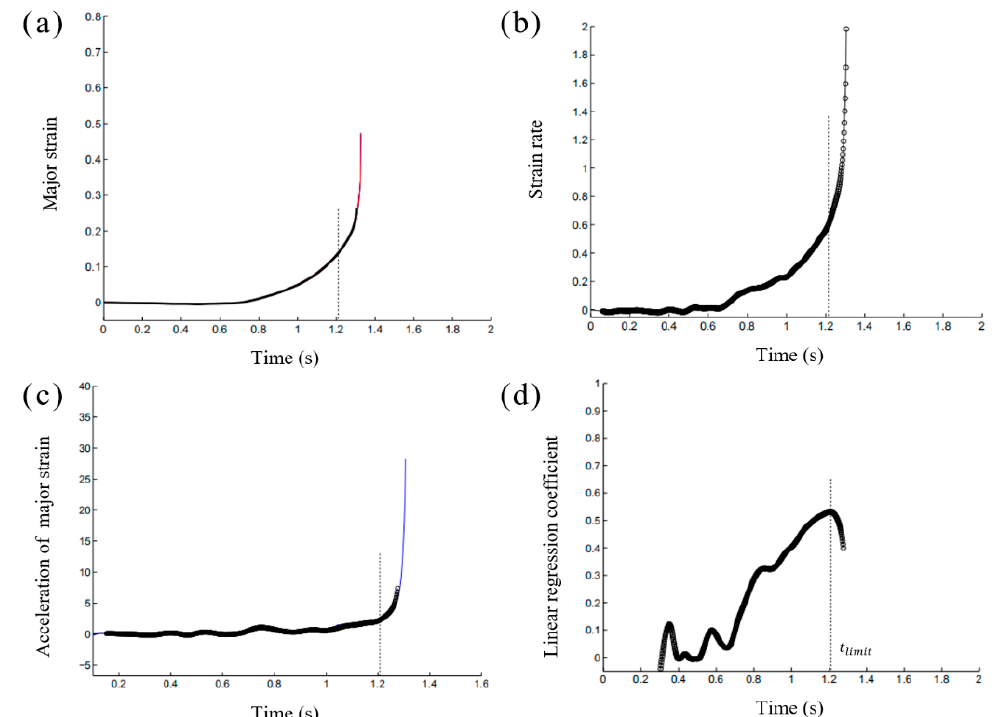
Figure 4. Time dependent method: ( a ) Evolution of major strain, ( b ) Evolution of major strain rate, ( c ) Acceleration of major strain, ( d ) Linear regression coefficient.